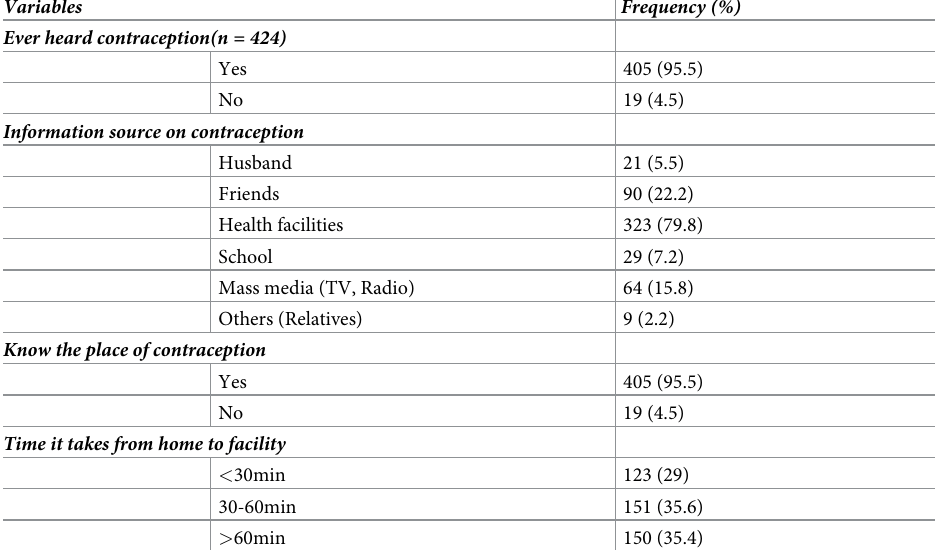
Table 2. Source of information and place to access modern contraceptives of currently pregnant married women youths of Kiremu district, Oromia, Ethiopia, 2020.